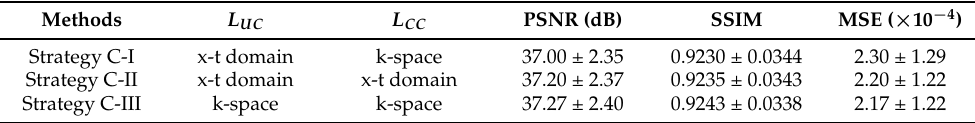
Table 5. Quantitative results of methods utilizing different loss function strategies at 8-fold accelera- tion (mean ±